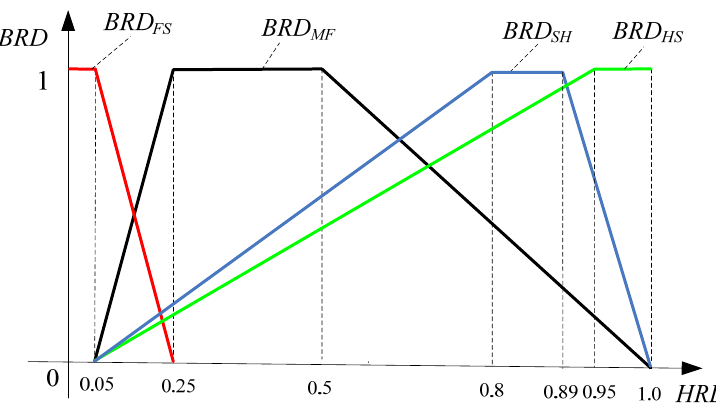
Figure 3. Relationship between BRD and HRD